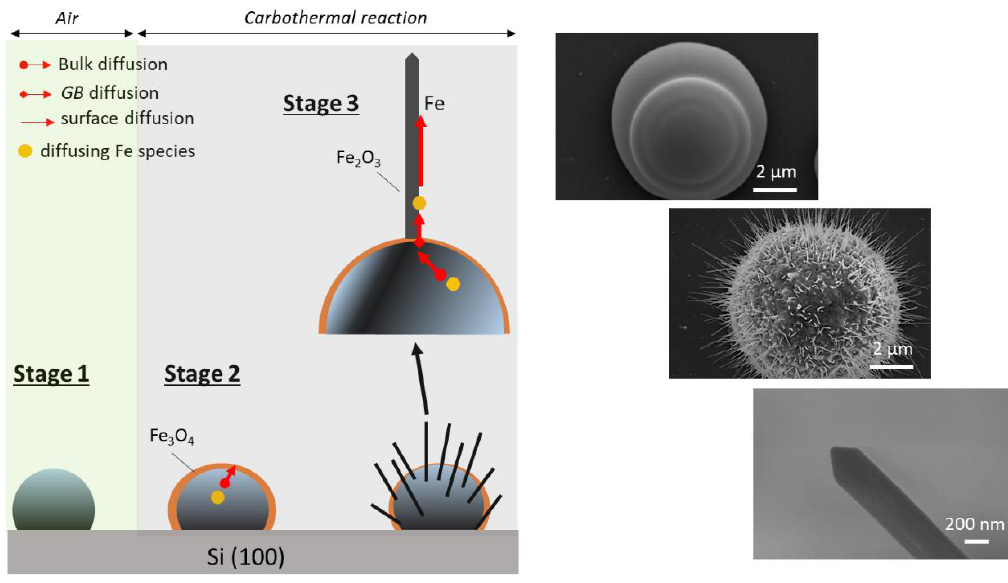
Figure 5. Plausible growth process of Fe 2 O 3 nanowires under the carbothermal route. Key stages can be identified: Stage 1, deposition of the Fe microsphere; Stage 2, initial stage of the carbothermal annealing of Fe microspheres transform into Fe 3 O 4 as the intermediate phase; Stage 3: final stage of carbothermal annealing, with the Fe 3 O 4 transforming mostly into Fe 2 O 3 nanowires. The stress gradient determines the direction of Fe 2 O 3 . Nanowires emerge from the Fe/Fe 3 O 4 interface to outward stress-free Fe 2 O 3 nanowire. Different types of pathways, such as bulk, grain boundary (GB), and surface diffusion, can assist in the transport of Fe across the interfaces. Representative SEM images of the Fe microsphere generated by infrared pulsed laser ablation and the carbothermally synthesized iron oxide nanostructures are also shown in the figure.